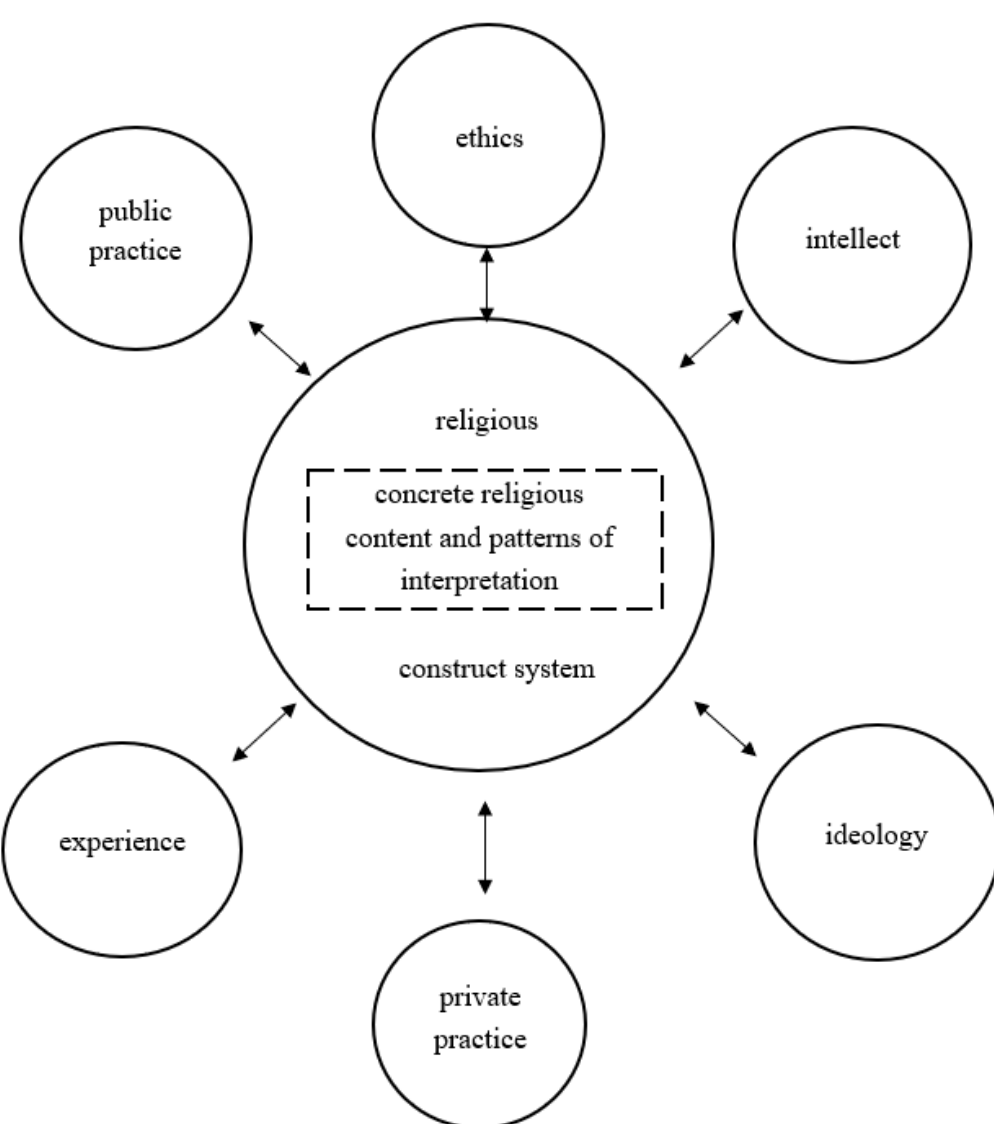
Figure 4. The extended model of religiosity by Huber. Based on Religiosität: Messverfahren und Studien zu Gesundheit und Lebensbewältigung (p. 88) by C. Zwingmann & H. Moosbrugger (Eds.), 2004, Münster: Waxmann. © by Waxmann.